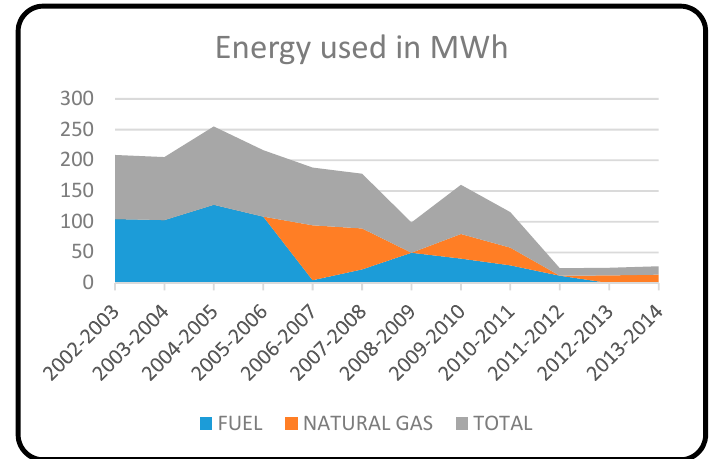
Figure 11. Energy use in Organic Cooperative greenhouses. Source: Fieldwork